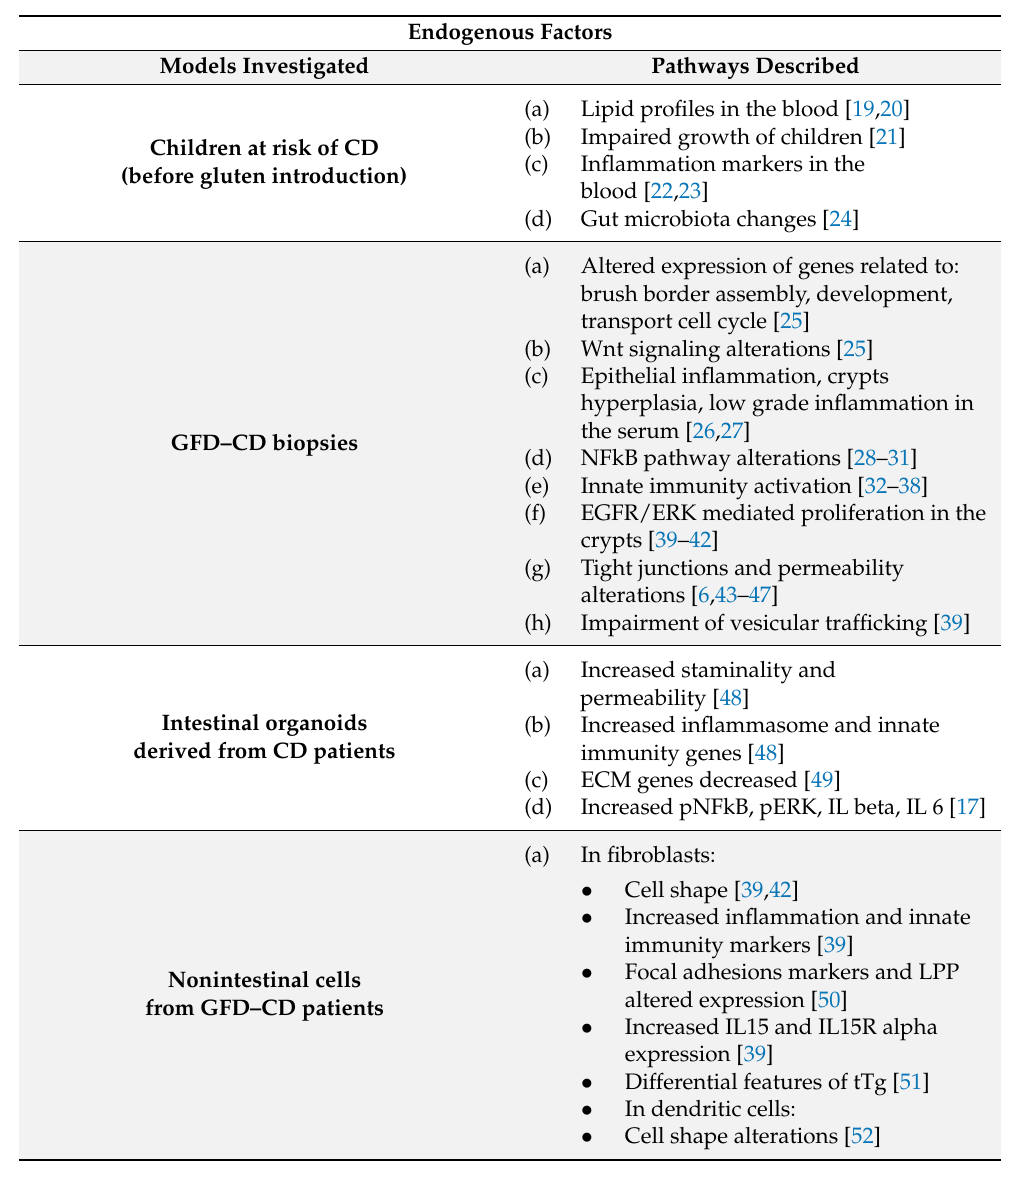
Table 1. Endogenous, constitutive alterations of several pathways have been described in different cellular models of CD. Most of these endogenous alterations can predispose one to inflammation. Some of these constitutive alterations can be regarded as biomarkers of CD. CD: celiac disease; Wnt: Wingless and Int 1; NFkB: nuclear factor kappa-light-chain-enhancer of activated B cells; EGFR: epithelial growth factor receptor; ERK: extracellular signal-regulated kinases; ECM: